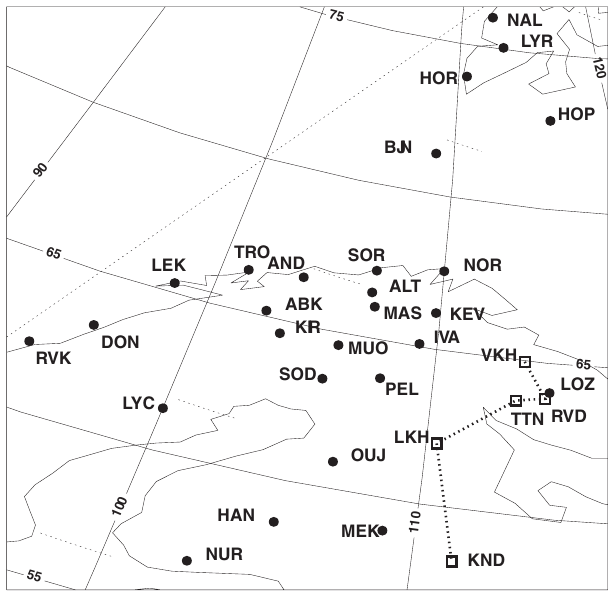
Fig. 1. A map showing the locations of stations for recording GIC in power lines (empty squares) and magnetometers from the IMAGE array (black dots). Dotted line shows the power transmission line. Geomagnetic coordinates are shown by solid lines, and geographic coordinates are denoted by dashed